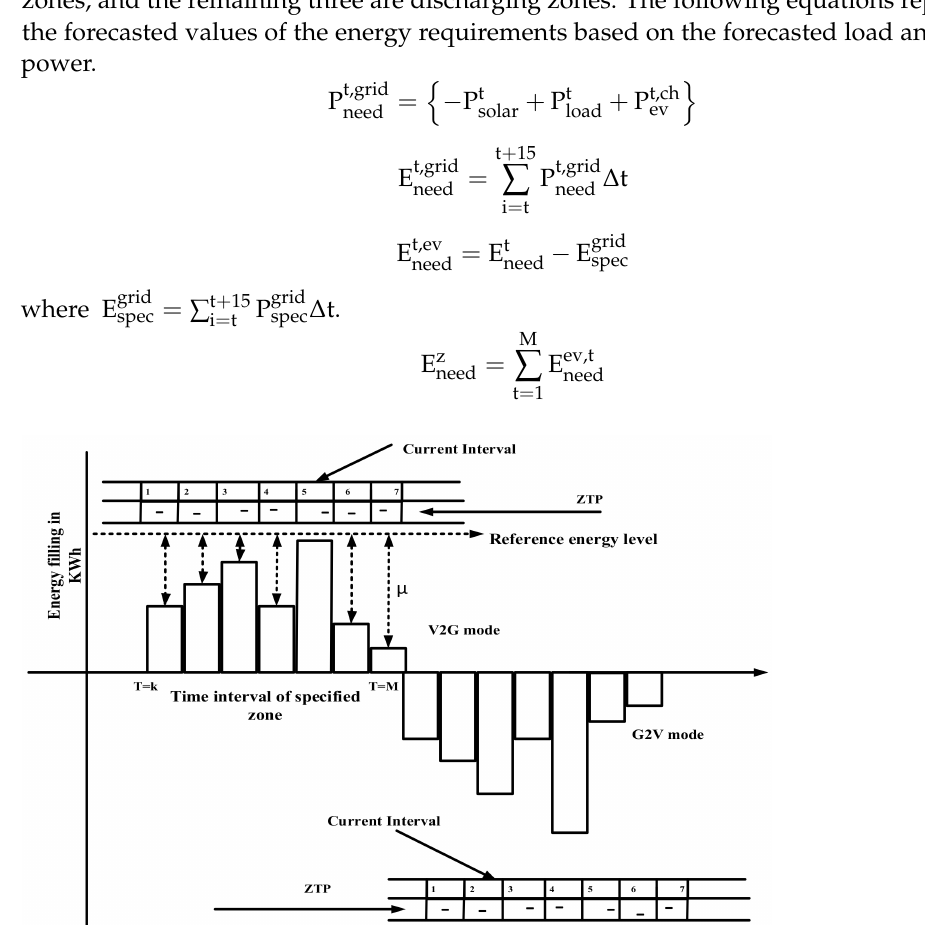
Figure 2. Representation of WFEDA for the